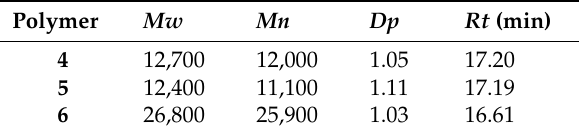
Table 4. Qualitative molecular weight and polydispersity of phosphate polymers 4 – 6